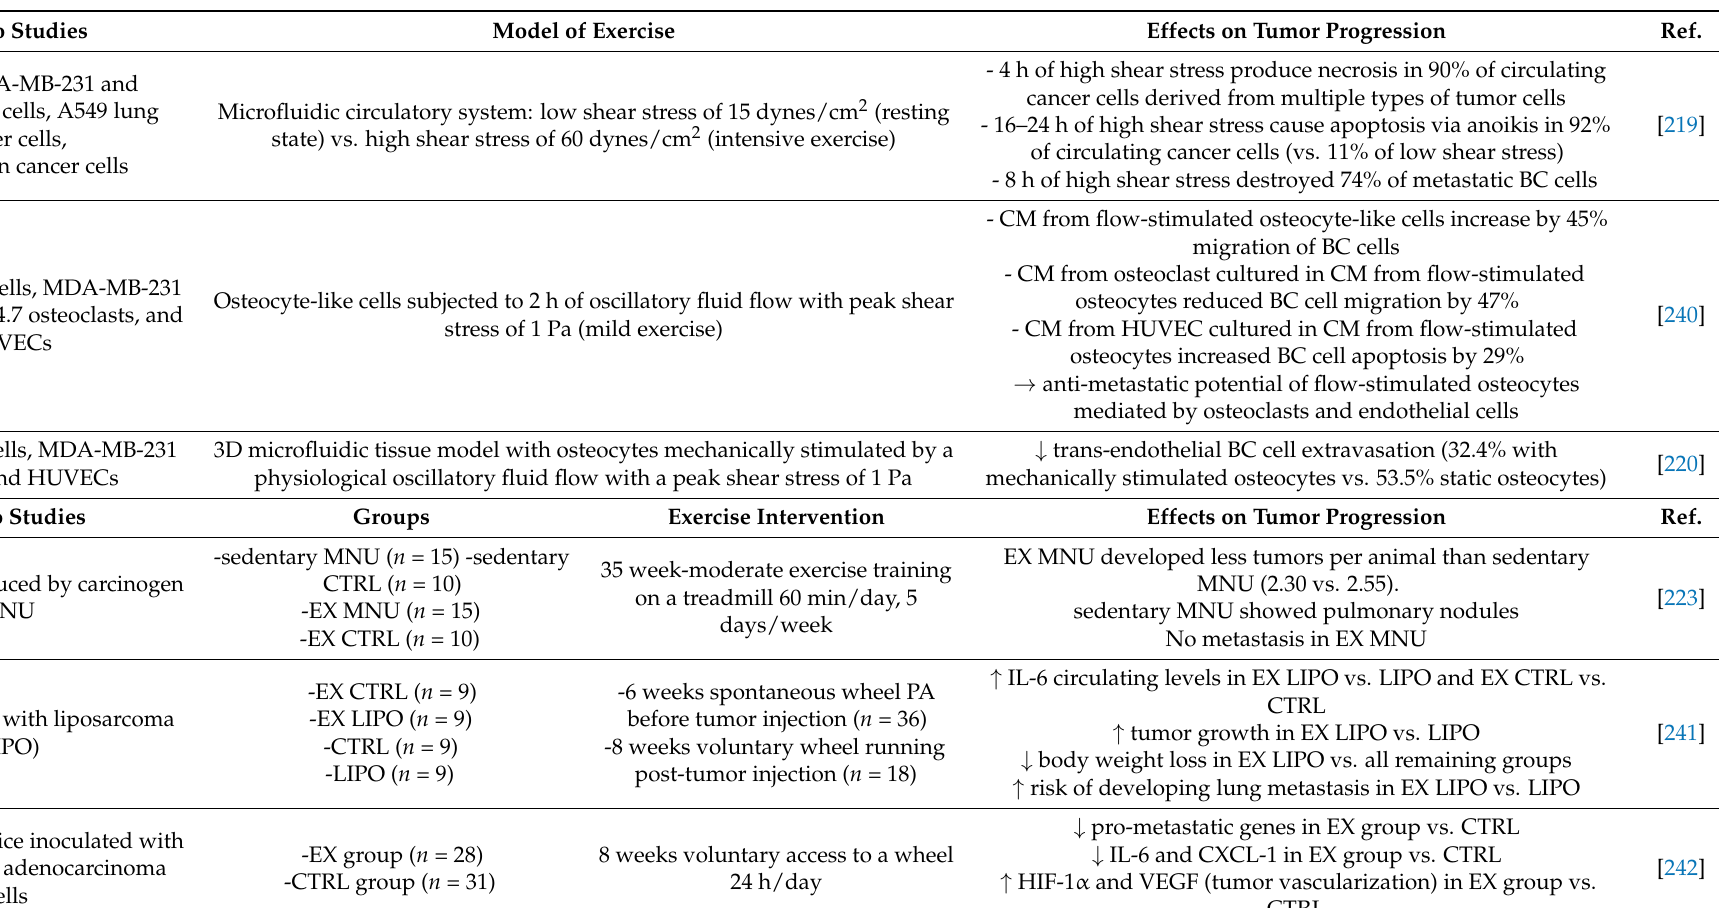
Table 2. Effects of exercise training on tumor